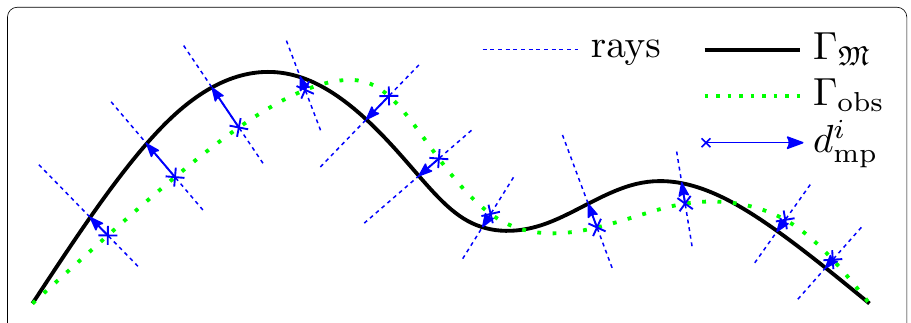
Fig. 1 Prototype sketch for pointwise distances d i mp from measurement points on the deformed interface (cid:5) M resulting from forward model evaluation, in given measurement (cid:5) obs , observed from experiment, to directions depicted as